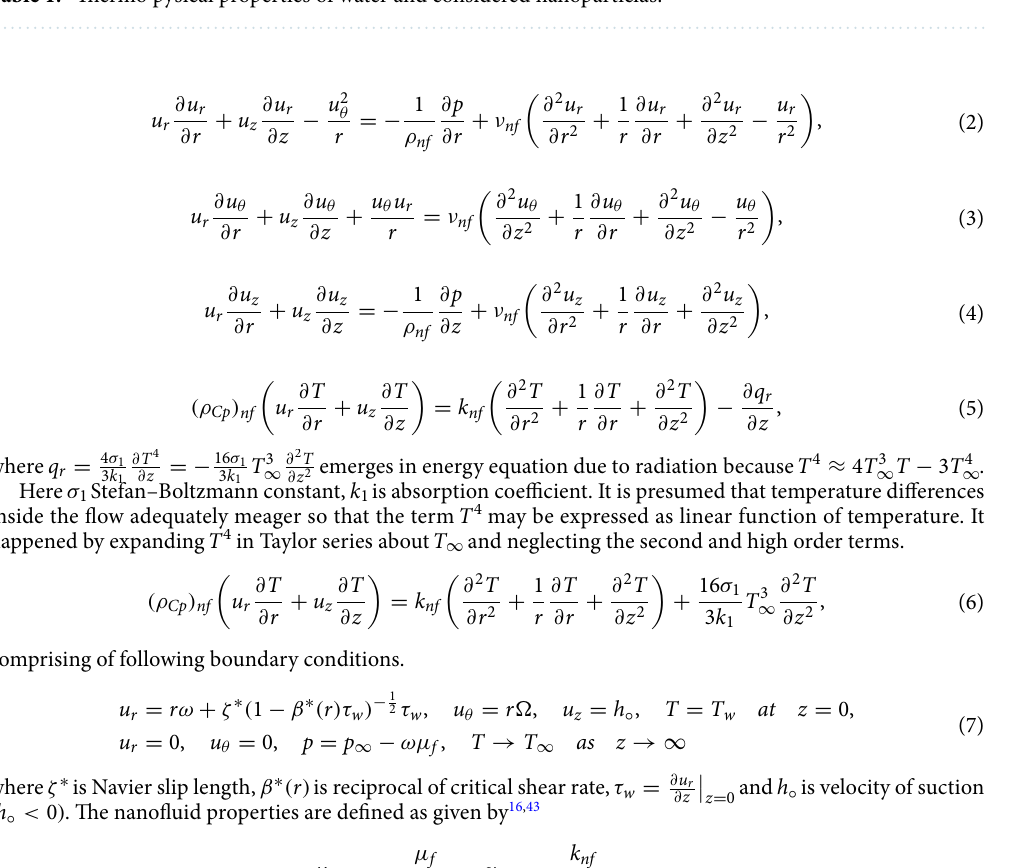
Table 1. Thermo pysical properties of water and considered